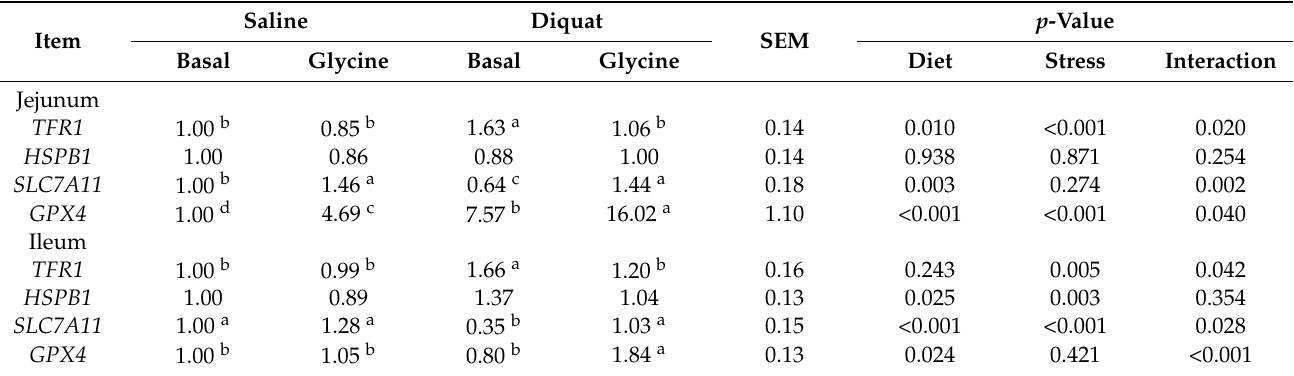
Table 6. The intestinal mucosal gene expressions of ferroptosis-related signals of the piglets fed glycine diets under oxidative